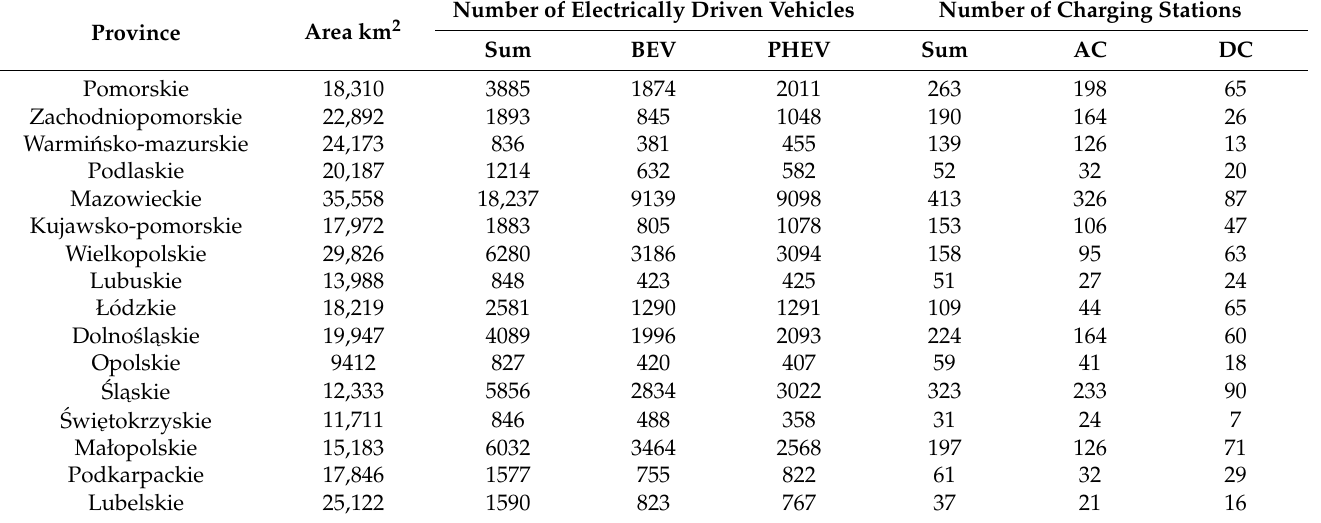
Figure 9. Province area as a function of the number of vehicles and charging stations for electric cars in Poland in September 2022: 1 — Pomorskie; 2 — Zachodniopomorskie; 3 —Warmińsko - mazurskie; 4 — Podlaskie; 5 — Mazowieckie; 6 — Kujawsko-pomorskie; 7 — Wielkopolskie; 8 — Lubuskie; 9 — Łódzkie; 10 —Dolnośląskie; 11 — Opolskie; 12 —Śląskie; 13 —Świętokrzyskie; 14 —Małopolskie; 15 —Podkarpackie; 16 — Lubelskie. Table 2. Detailed list of the number of vehicles and the number of charging outlets in individual Polish provinces in September 2022.